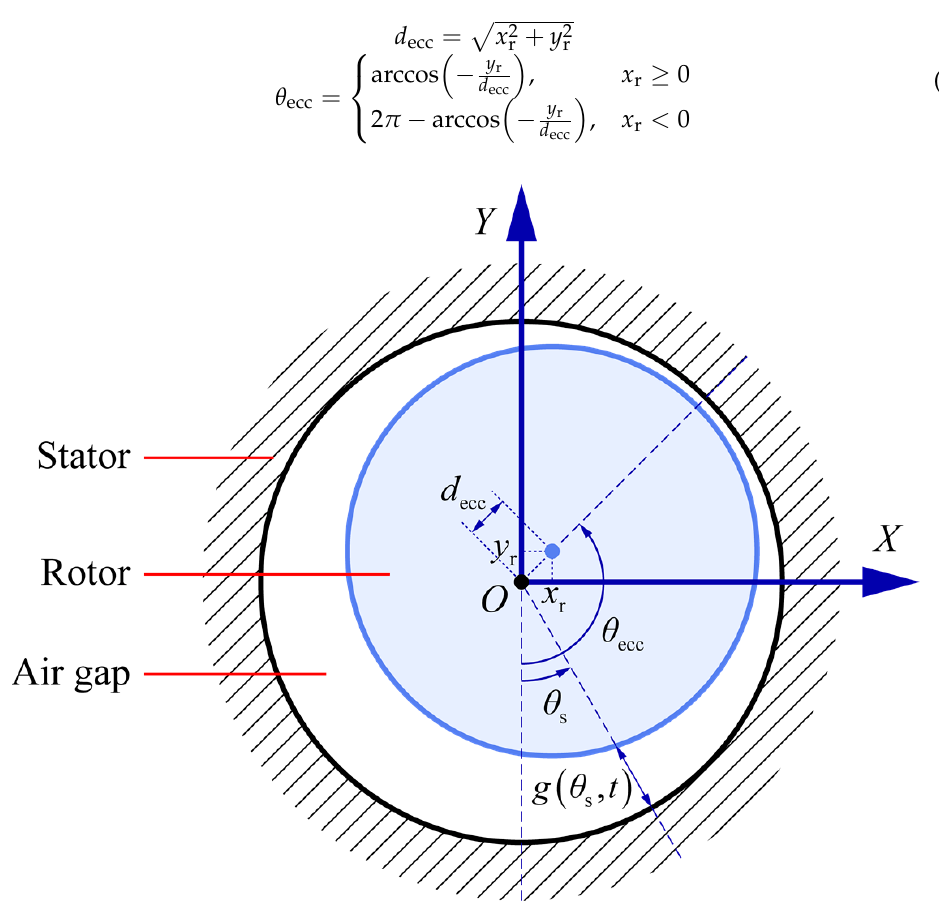
displacement in both directions at moment t , the rotor eccentricity and eccentricity angle introduced due to bearing failure are